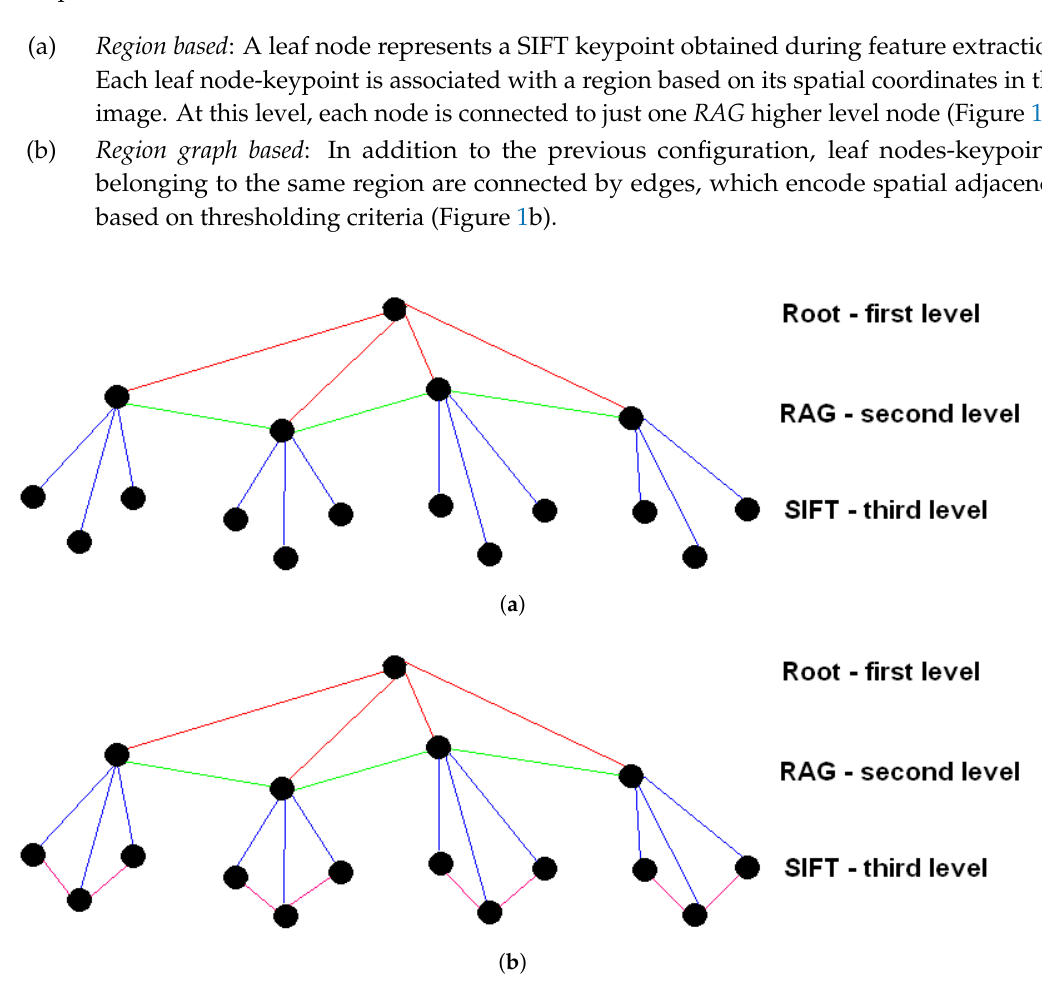
Figure 1. Region-based ( a ) and region graph-based ( b ) configurations. RAG, Region Adjacency